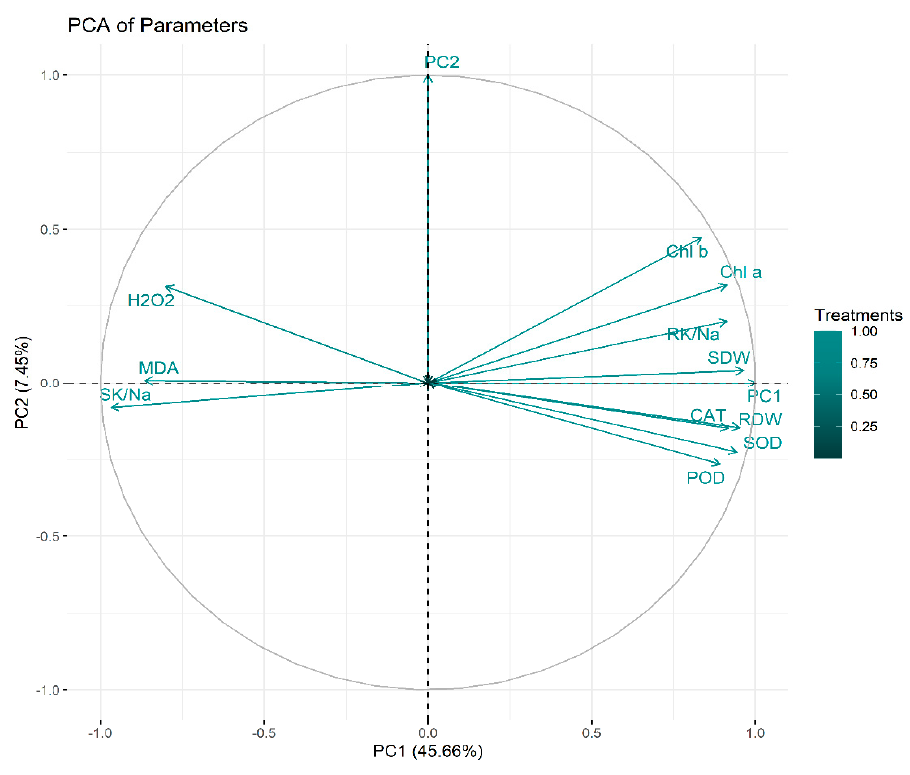
Figure 6. Principal component analysis. RDW: root dry weight (g), SDW: shoot dry weight (g), Chl a: chlorophyll a contents (mg g − 1 FW), Chl b: chlorophyll b (mg g − 1 FW), POD: peroxidase activity (U g − 1 m − 1 FW), SOD: superoxide dismutase activity (U g − 1 m − 1 FW), CAT: catalase activity (U g − 1 m − 1 FW), MDA: malonaldehyde contents (µmol g − 1 FW), H 2 O 2 : hydrogen peroxide contents (µmol g − 1 FW), SK/Na: shoot potassium/sodium ratio, RK/Na: root potassium/sodium ratio.